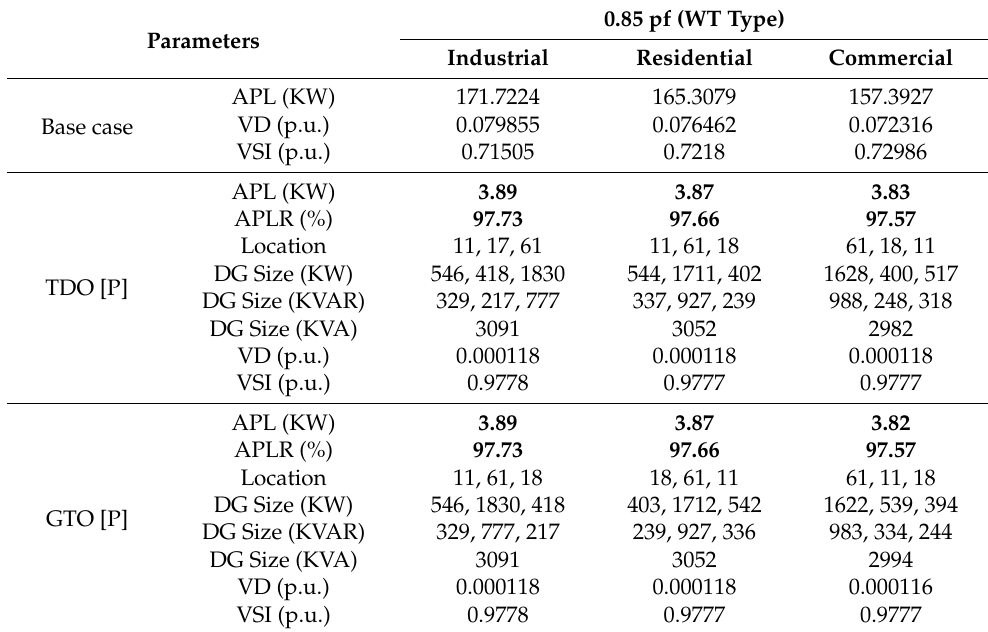
Table 14. Results of the OADG for a 69-bus RDN for the SOF (APL minimization) at 0.85 pf (WT Type) in a VP load